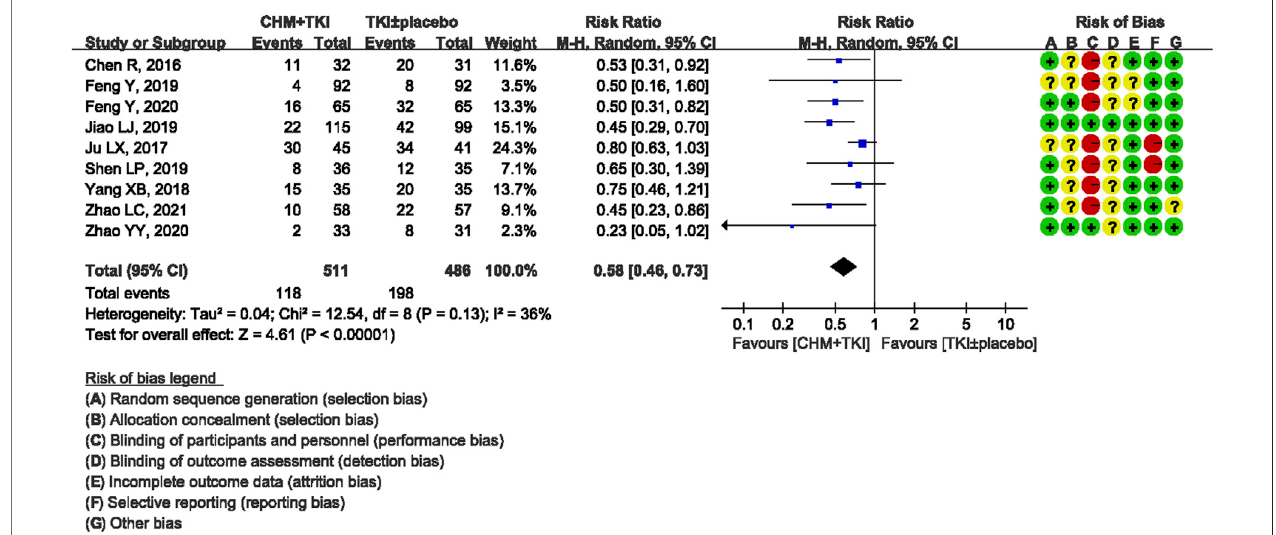
FIGURE 6 | Forest plot showing incidence of cutaneous toxicity.